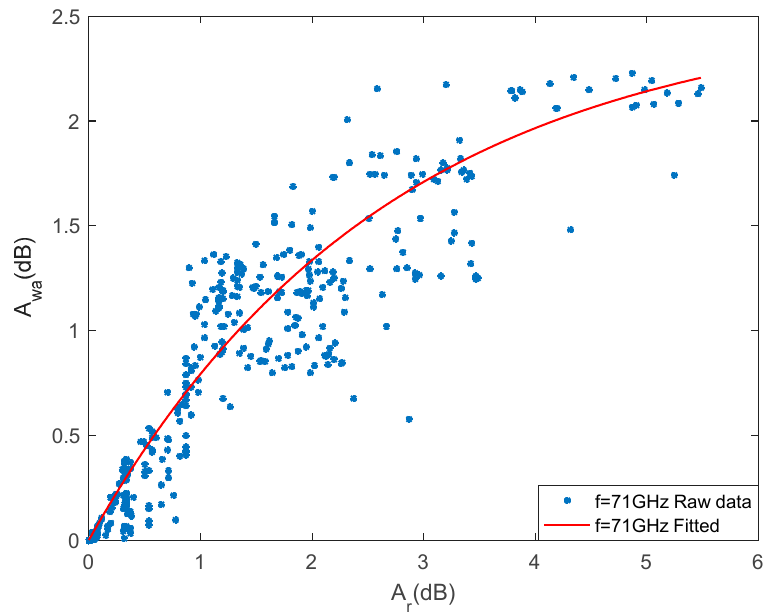
Figure 5. Curve fitting of A r and A wa at 71 GHz.